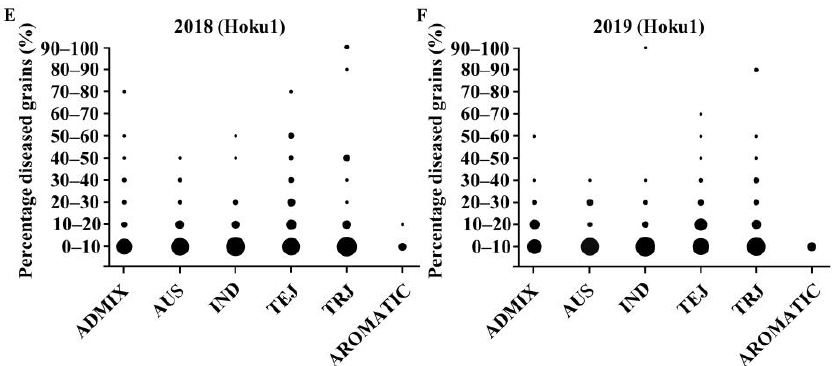
Figure 1. Grouping and identification of panicle blast resistance. ( A ) Identification and grading of panicle blast resistance. ( B ) Distribution of 232 rice germplasms in subgroups. IND: indica; TEJ: tropical japonica; TRJ: temperate japonica; AUS: Autumn Rice, which can be classified as indica; ADMIX: mixed variety; AROMATIC: aromatic variety, which can be classified as japonica. ( C , D ) Frequency distribution of panicle blast resistance scores in fields at the Nanjing Experimental Base in Jiangsu province in 2018 and 2019, respectively. ( E , F ) Distribution of blast resistance scores of RDP1 in the six sub-populations; the area of black circles represents the accession numbers.